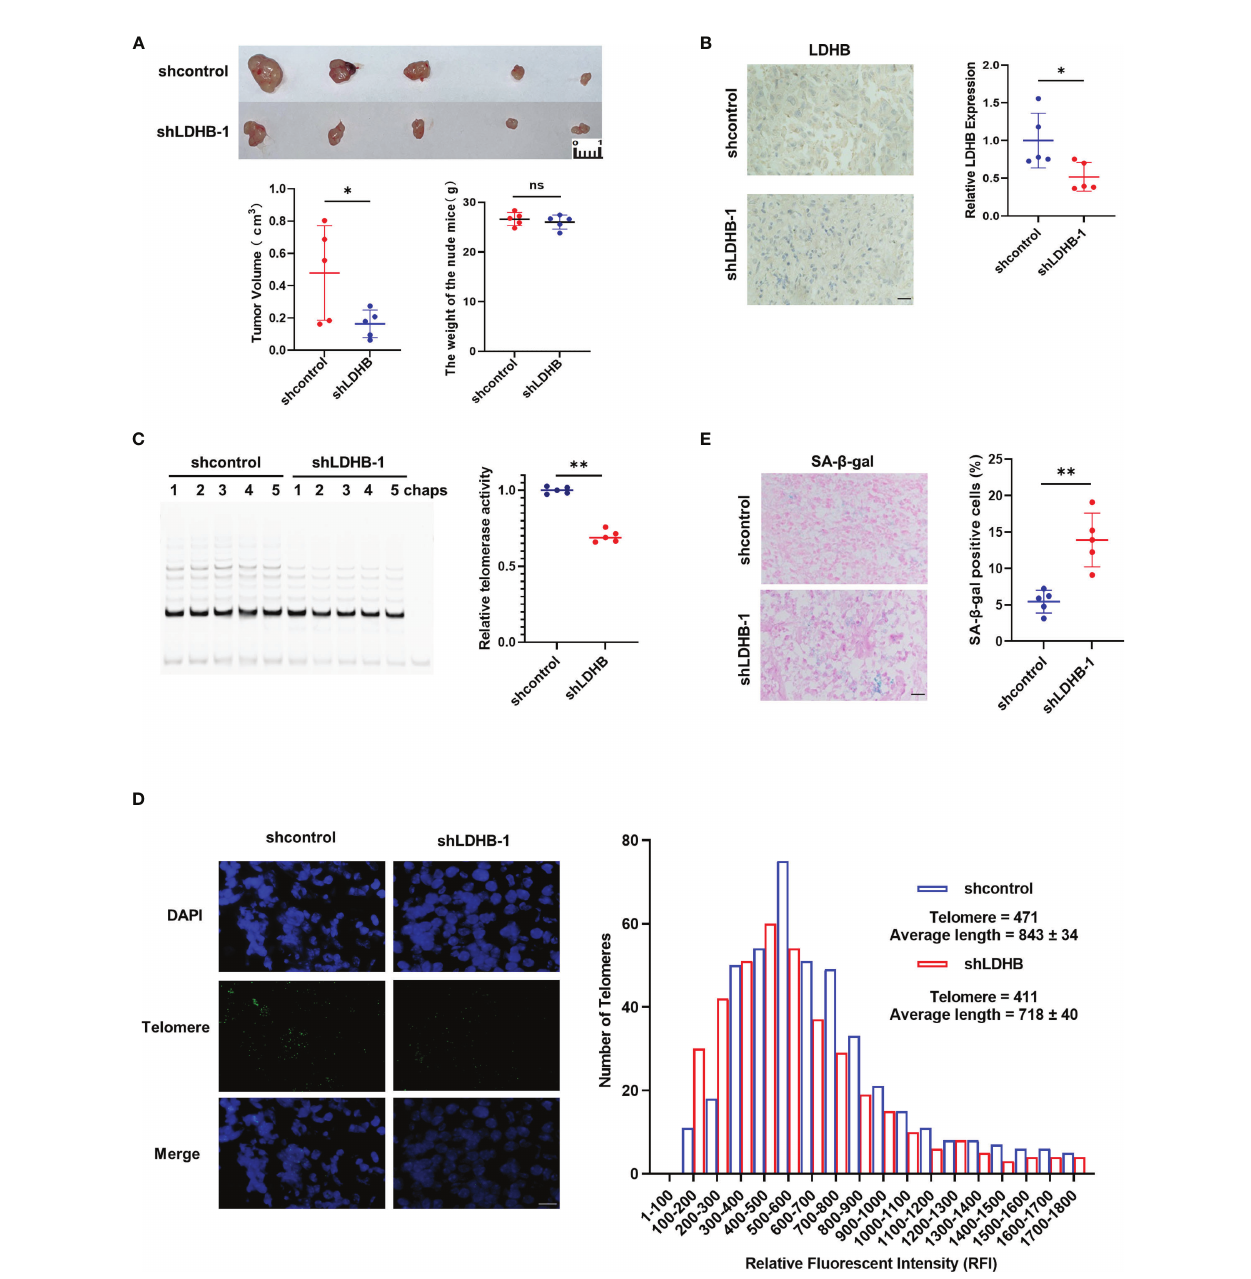
FIGURE 4 | Knockdown of LDHB inhibit the proliferation of PANC-1 cells in nude mice. (A) PANC1 cells stably expressing shcontrol or shLDHB were injected subcutaneously in nude mice (n=5 for each group). Tumor value and mice bodyweight were measured 1 month later. (*P <0.05). (B) The expression of LDHB in tumors of two groups was detected by immunohistochemistry (*P<0.05). Scale bar, 50 m m. (C) Telomerase activity in tumors of each mice were detected by TRAP (**P < 0.01). (D) Telomere length was evaluated in paraf fi n embedded sections of tumor tissue using Q-FISH. Generated histograms of individual telomere length distributions [shorter to longer, lower to higher relative fl uorescent intensity (RFI)] for shcontrol (blue) and shLDHB (red). The average telomere length is shown as the average RFI ± SD. Scale bar, 50 m m. (E) Representative frozen tumor sections from mice were subjected to SA- b -gal staining followed by eosin staining. The right panel shows the percentage of senescence positive cells of each sample (**P<0.01). Scale bar, 50 m m. ns means no statistically signi fi